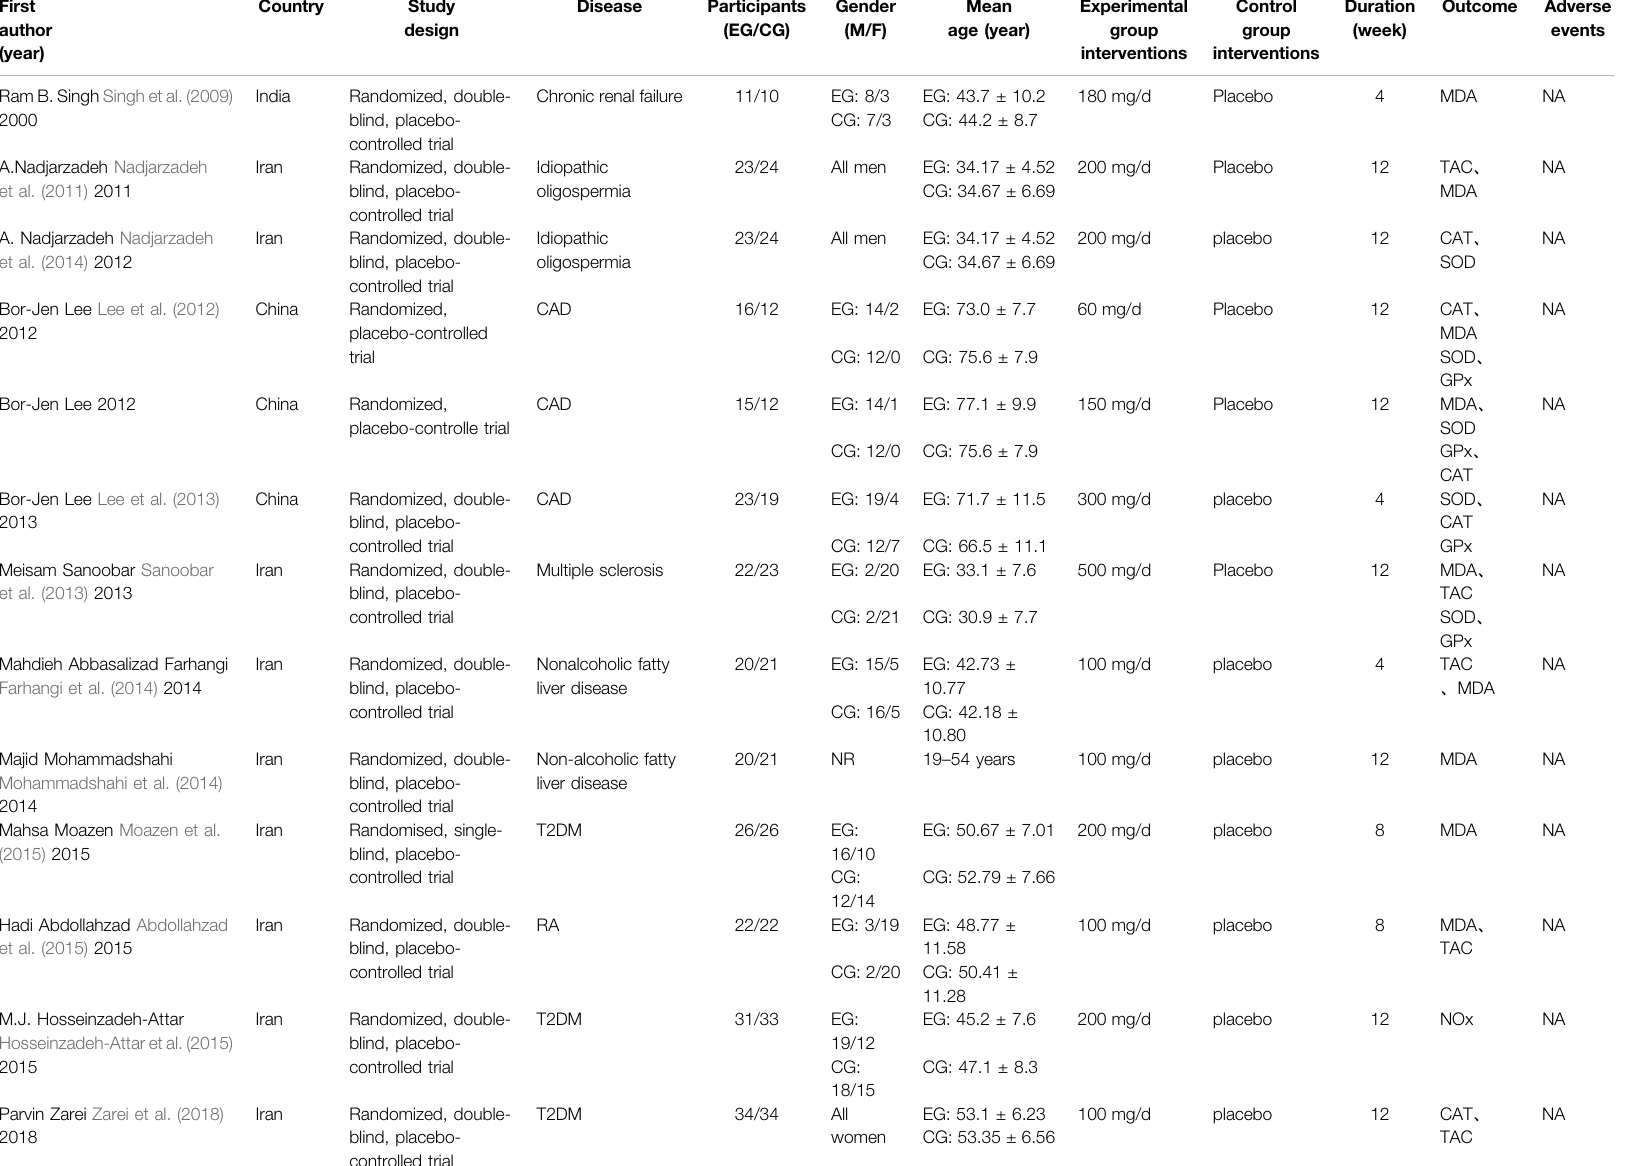
TABLE 1 | General characteristics of the included